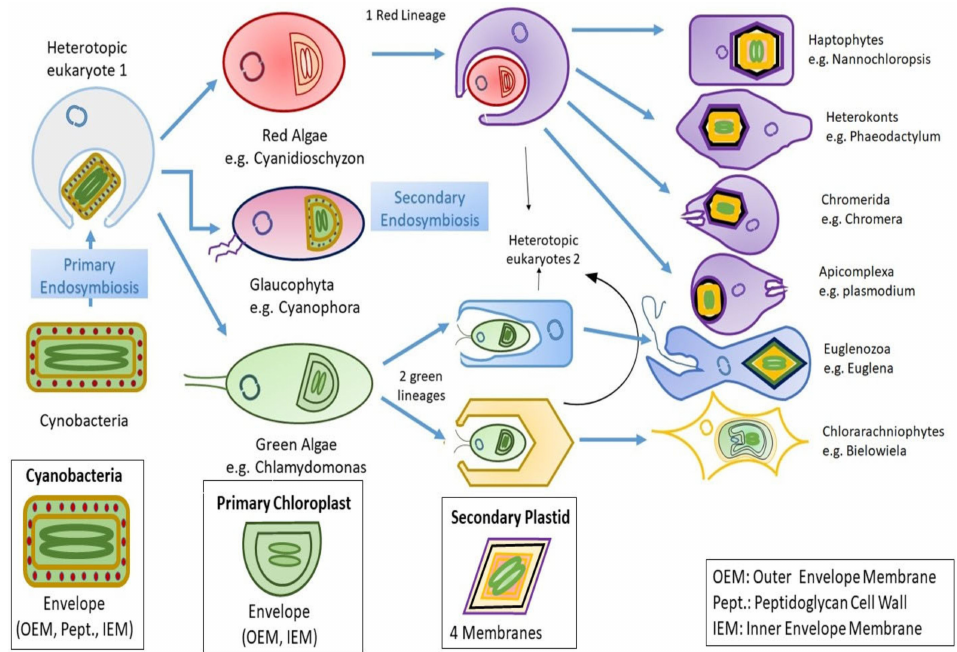
Figure 1. Diagrammatic representation of endosymbiosis: Primary endosymbiosis occurs when a heterotopic eukaryote engulfs a prokaryote (gram negative cyanobacteria), which leads to emergence of three lineages bearing primary chloroplast with two membranes that it vertically inherited from the cyanobacteria. Later on, the independent secondary endosymbiosis of green algae (eukaryote) by two unknown heterotopic eukaryotes that leads to emergence of Euglenozoa and Chlorarachinoophyte. Red algaealsogothroughsimilarmechanismofsecondaryendosymbiosis. Theconsequentsecondaryplastid contains four membranes, out of which two are the ones that were inherited from the cyanobacteria during primary endosymbiosis, and the other two are still